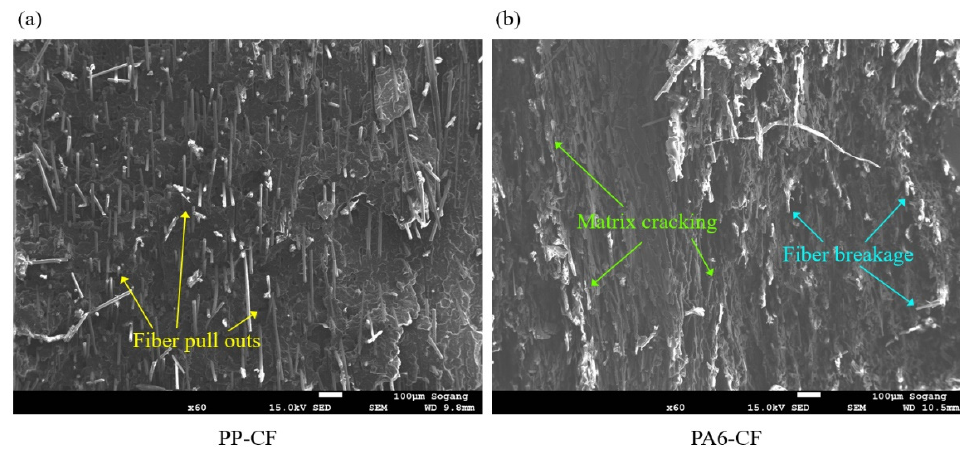
Figure 9. SEM images on fracture cross-sectional surface of ( a ) PP-CF and ( b ) PA6-CF.